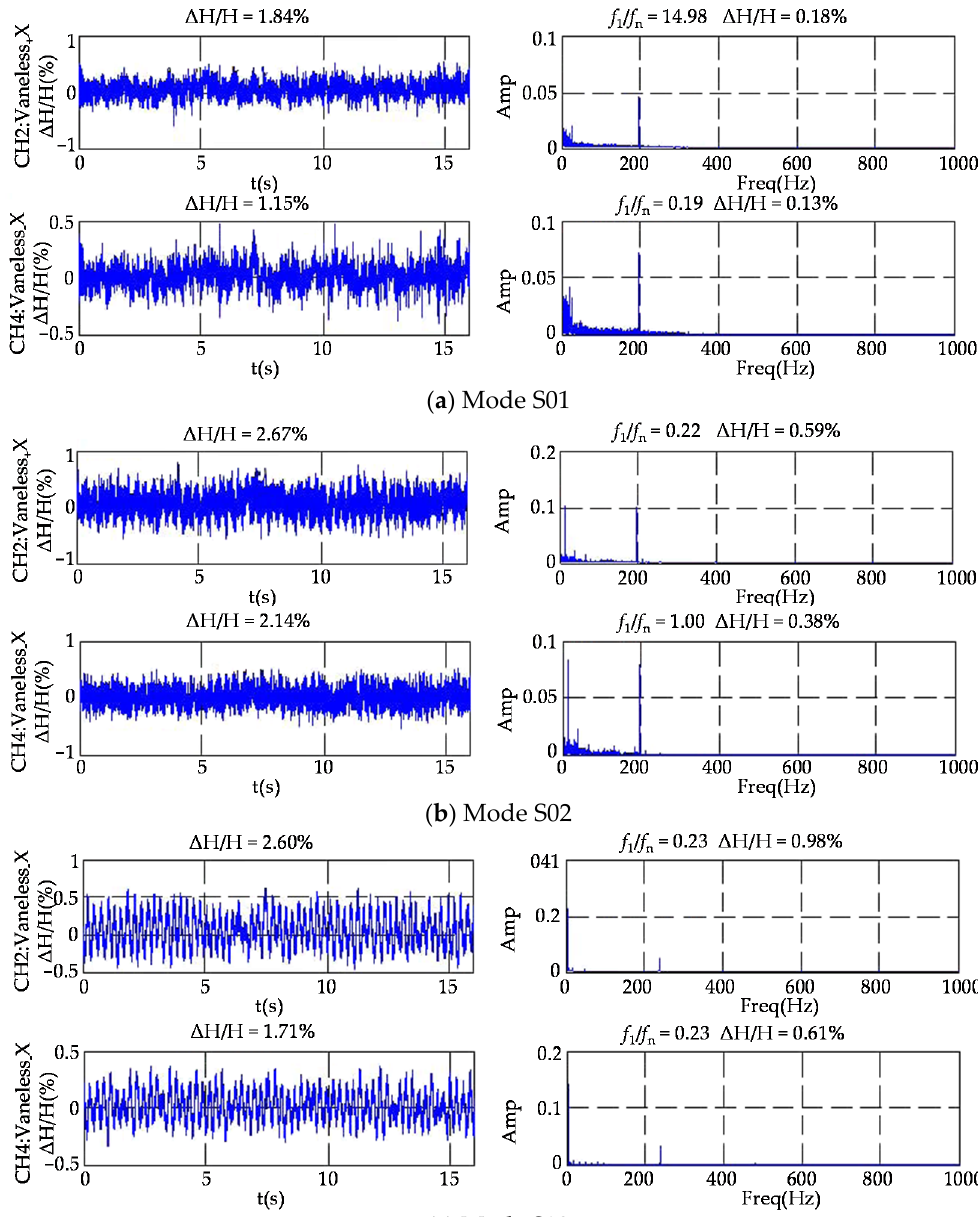
Figure 8. Pressure fluctuations in vaneless space.